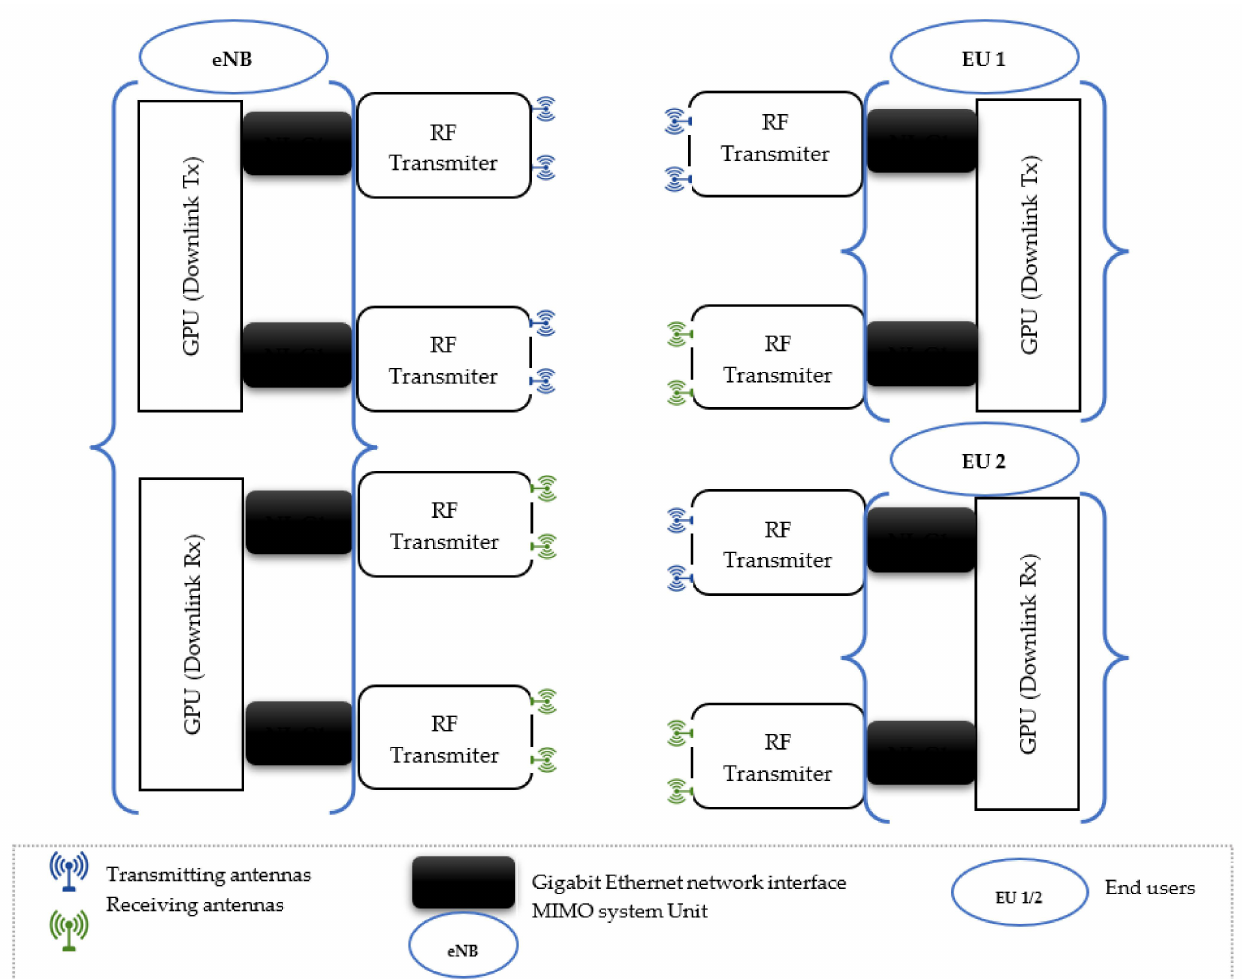
Figure 6. 4 × 4 3GPP TDD LTE-A MIMO system